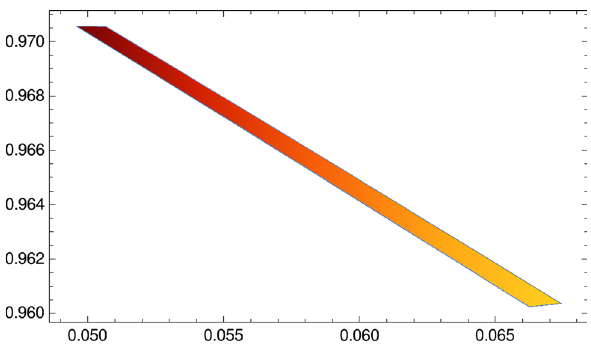
Fig. 12 Parametric plot of n s vs r ( x axis ≡ r and y axis ≡ n s ) for 0 . 001 (cid:2) (cid:13)/ H 0 (cid:2) 0 . 0026, 109 (cid:2) μ 2 (cid:13)